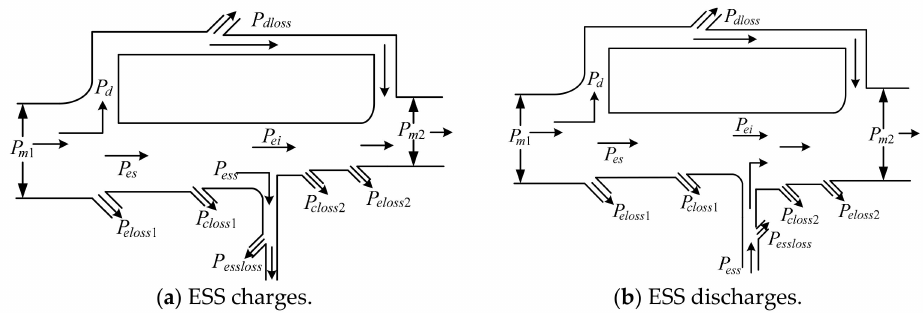
Figure 2. Power flow of the